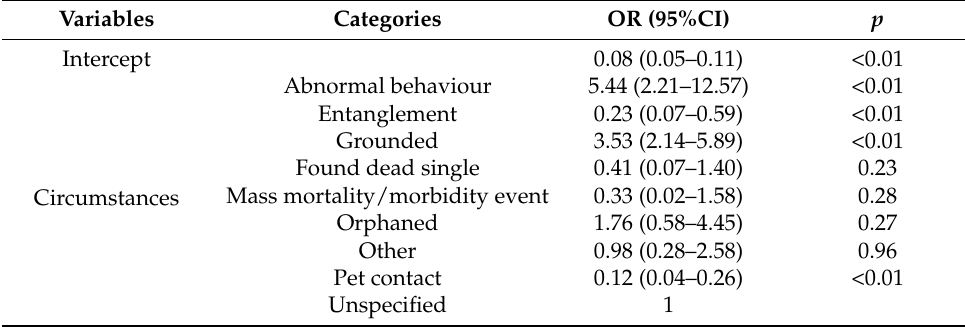
Table 5. Effects of circumstances on infection status.